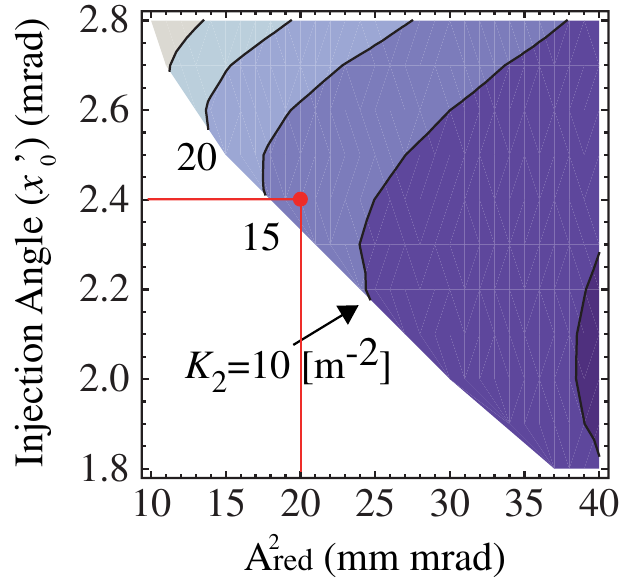
FIG. 7. (Color) The field strength K 2 of the PSM05 is shown as a function of the square of the reduced injection amplitude A 2 red and the injection angle x 0 0 . The white area has no solution of K 2 because the condition of (11) is not satisfied. Calculations were made with x 0 ¼ 27 mm and A 2 red ¼ 20 mm mrad using Eq. (12).